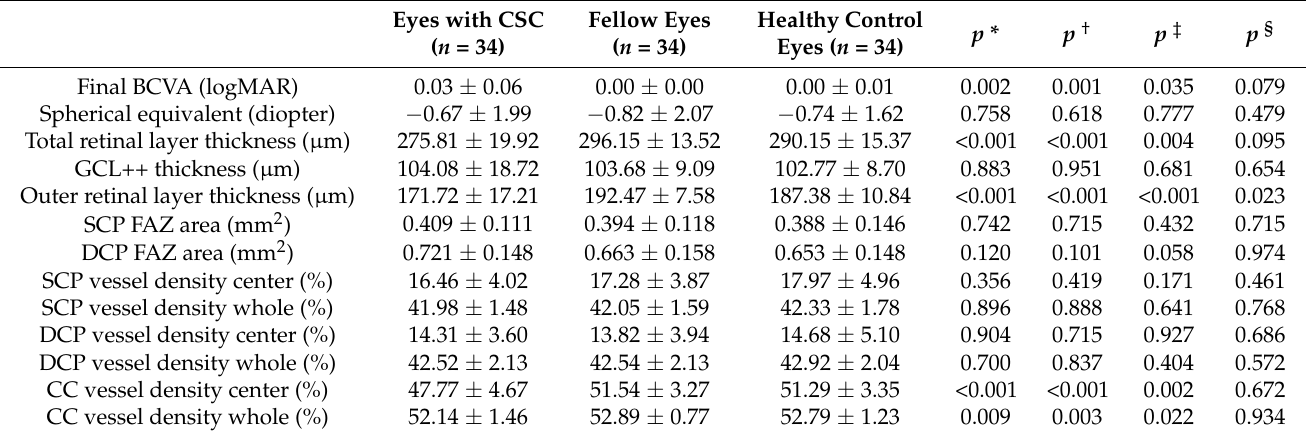
Table 2. Comparison of retinal layer thickness, FAZ area, and vessel density between the eyes with CSC, fellow and healthy control eyes.